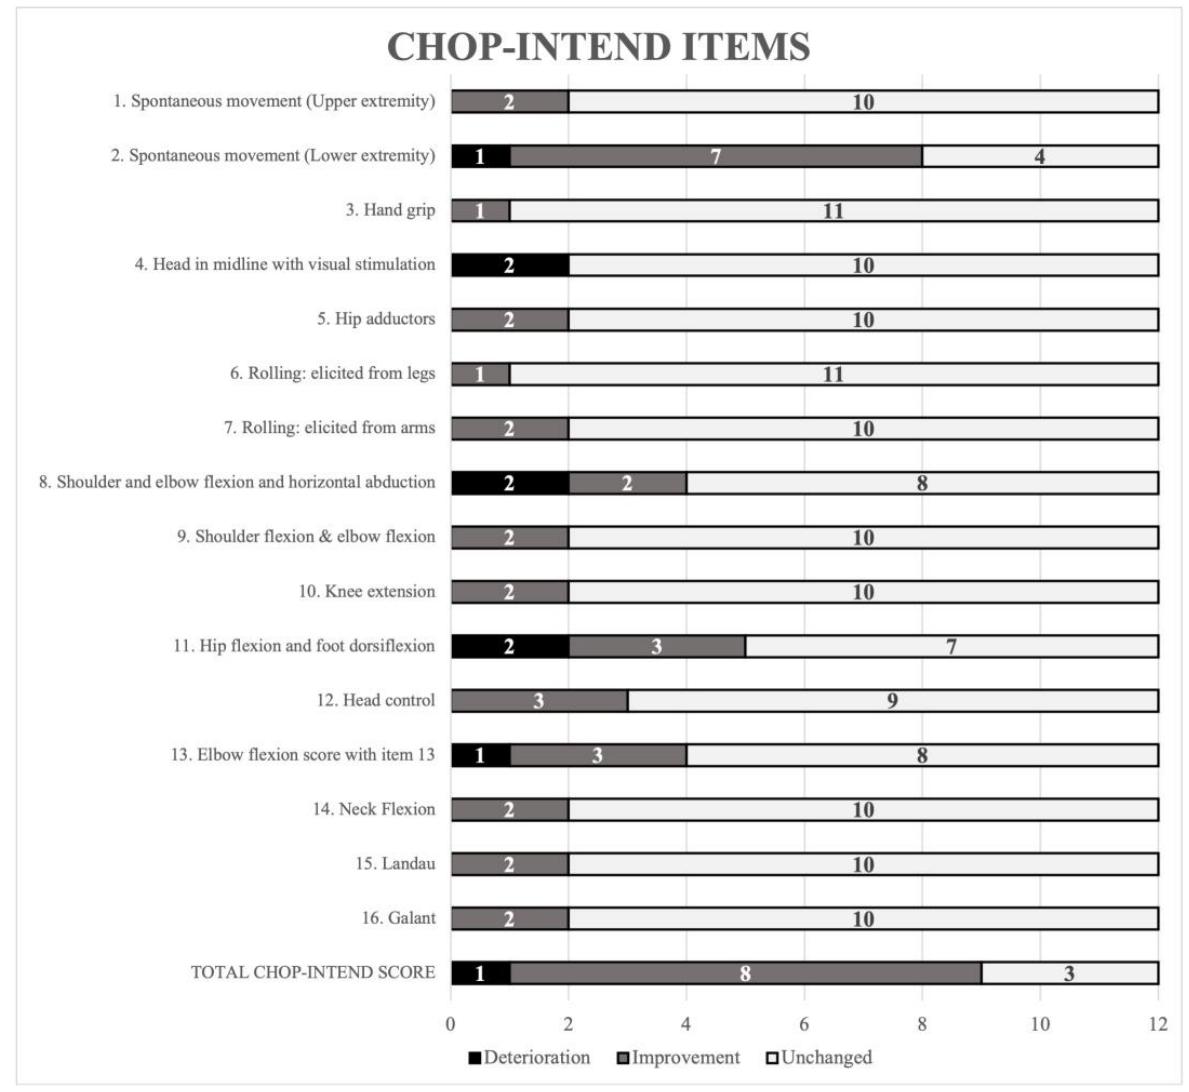
Figure 1. Number of children with deterioration, improvement or unchanged in individual CHOP- INTEND scale items .